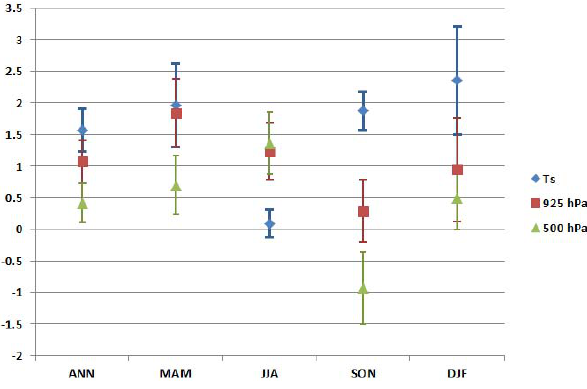
Fig. 9. 70–90 ◦ N average temperature trend from 1998 to 2011 in units of change (in K) over the 14yr, as in Table 4. All the trends here are from pure observations (either GISTEMP or IGRA data) and not from the reanalyses. The error bar represents ± standard error of the trend.